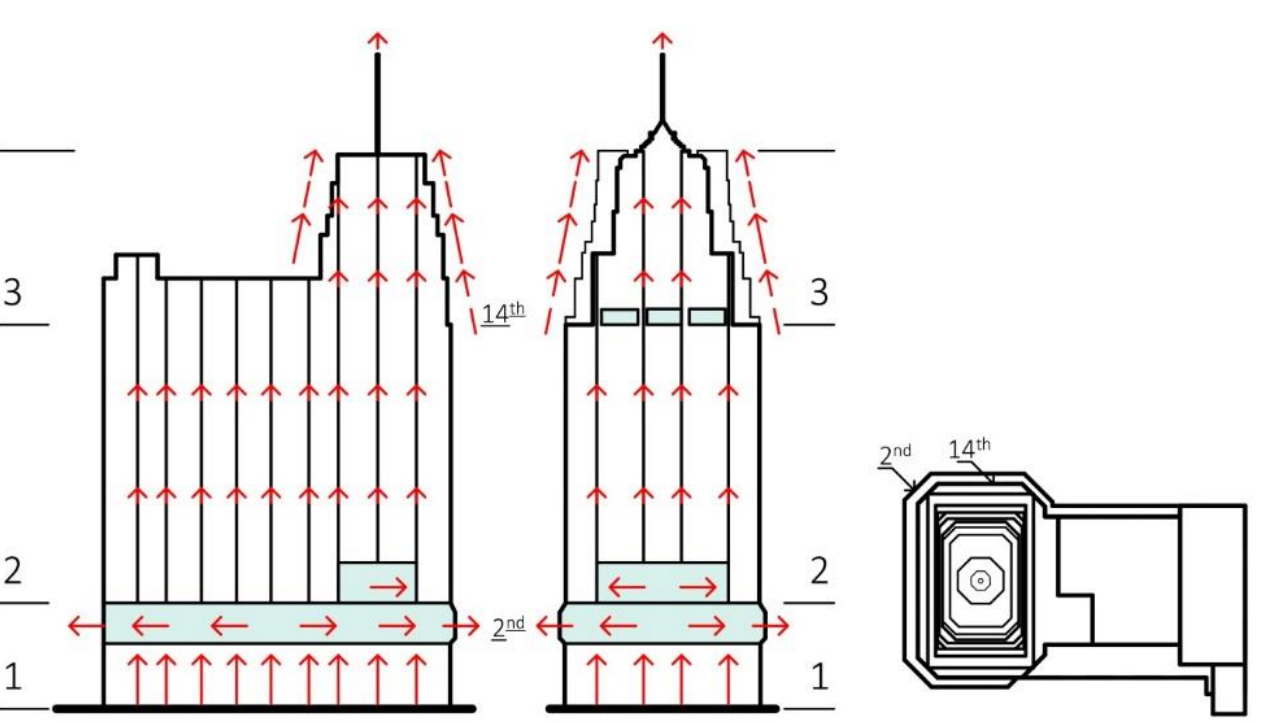
Figure 18. JSS Building—tripartite scheme and gradually decreasing plan, scheme of tension